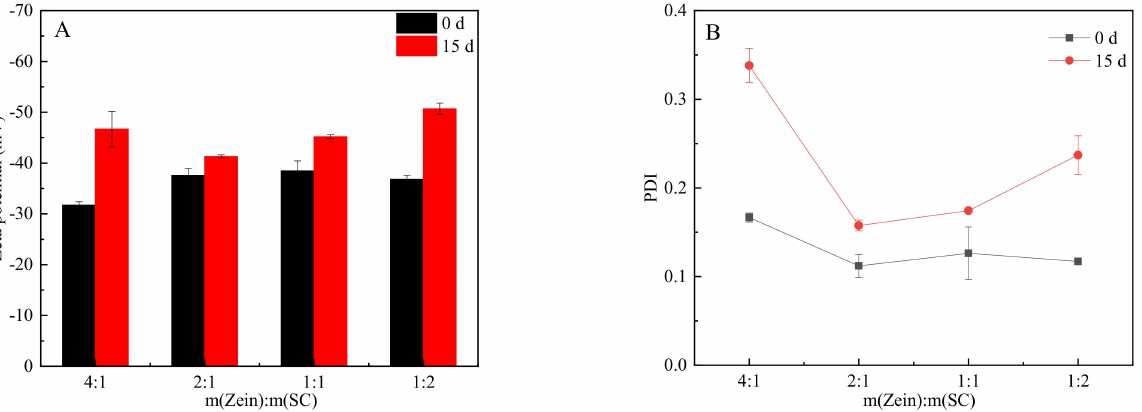
Figure 7. Zeta potential and PDI of CA-loaded nanoparticles with zein/SC mass ratios of 4:1, 2:1, 1:1, and 1:2. ( A ) The zeta-average potential. ( B ) PDI (black represents freshly prepared; red represents standing after 15 storage